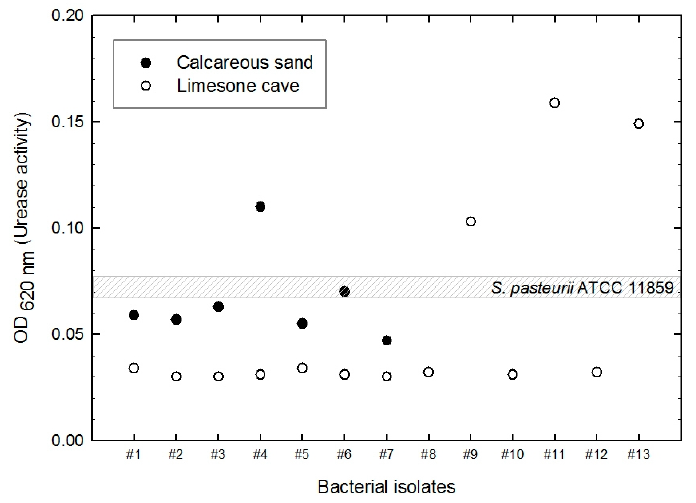
Figure 5. Urease activity of 20 microbial isolates.